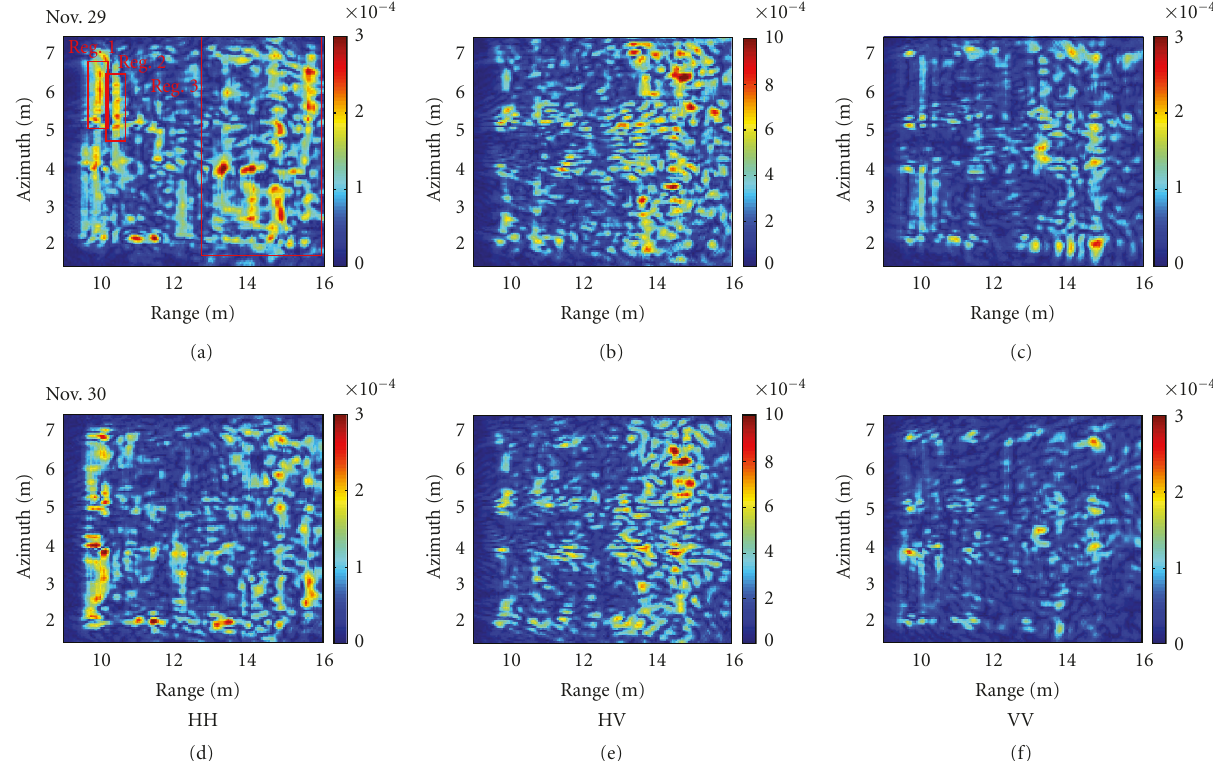
Figure 4: Reflections from simple house taken by GB SAR in HH, HV, and VV